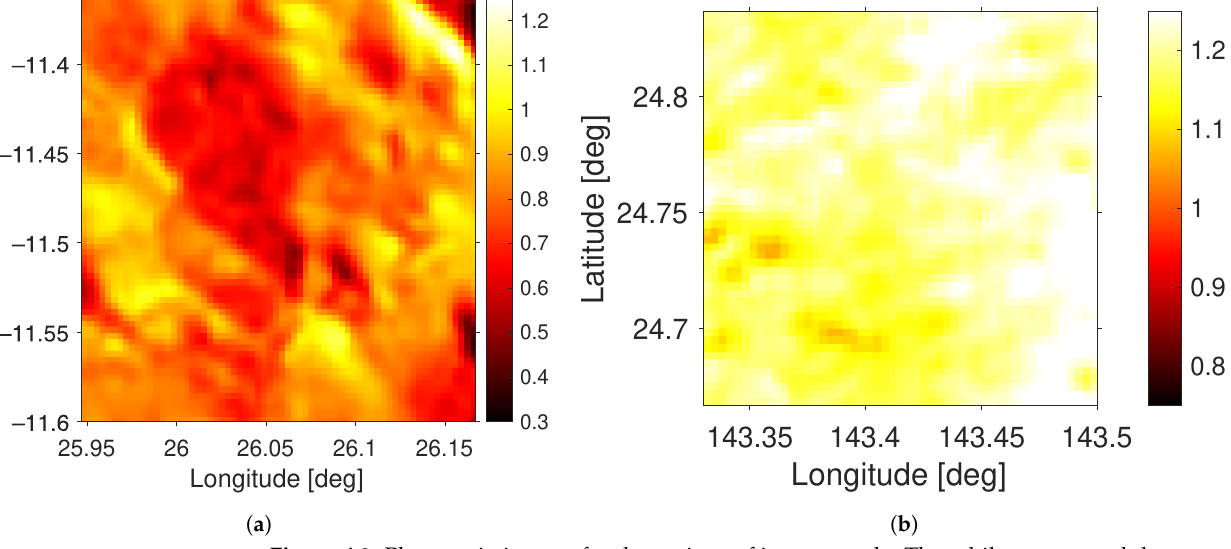
Figure A9. Phase ratio images for the regions of interest at the Theophilus crater and the western basin rim of Mare Moscoviense. The phase ratio images are correlated with the macroscopic and microscopic surface roughness [63]. In the Theophilus crater, the correlation with the OHIBD values is r = 0.126, near Mare Moscoviense it is r = 0.043 and r = 0.096 for morning and midday,